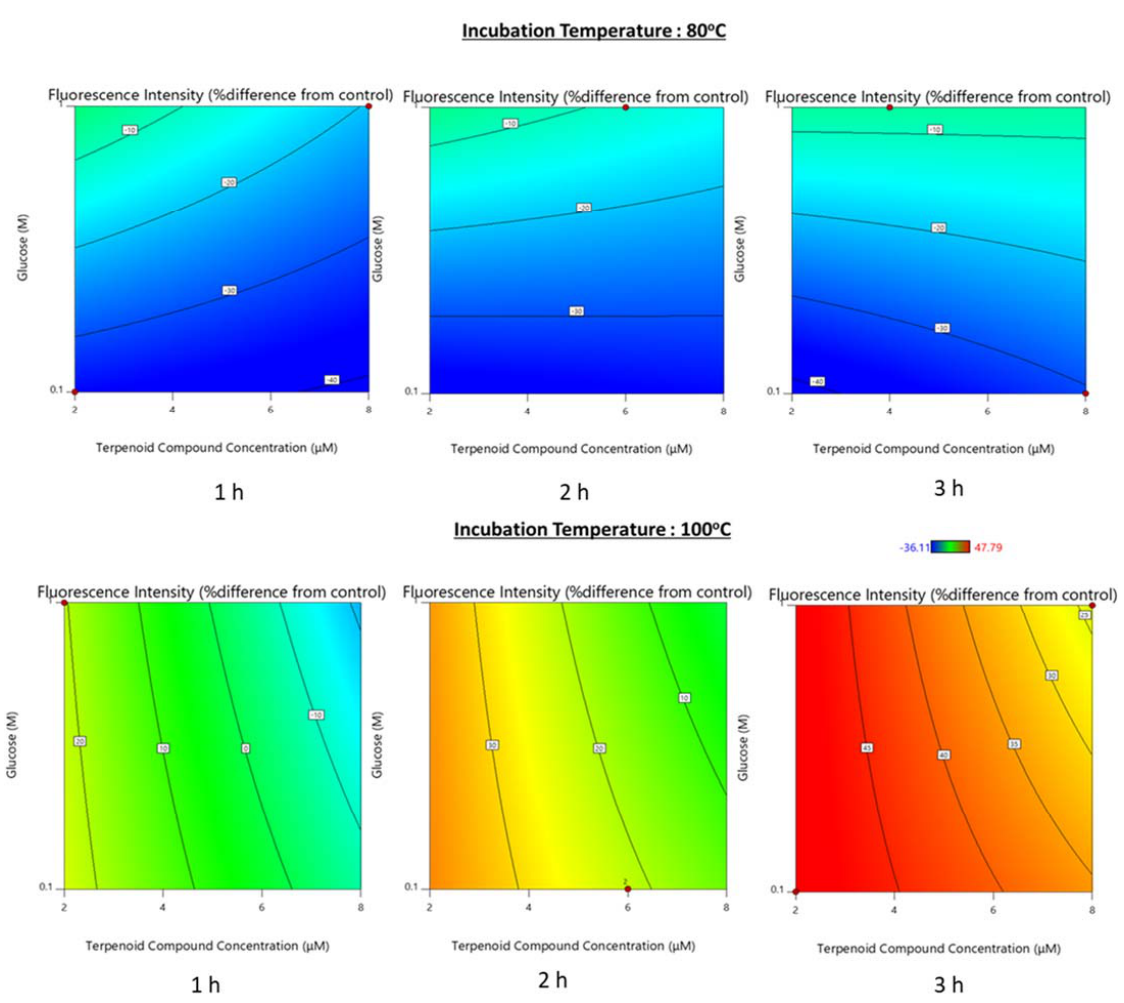
Figure 9. The effect of terpenoid compound concentration and glucose concentration on fluorescence intensity expressed as percentage difference from control (no terpenoid compound added) at pH 7.2 and 80 °C and 100 °C. Figures indicate average values of all three terpenoid compounds (linalool, aniseed oil and thymol).